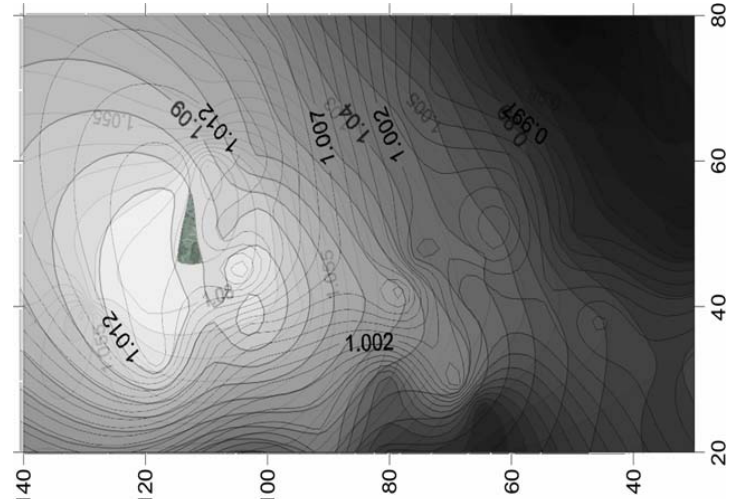
Figure 5. Chart for the relationship between θ 20 < Re < D